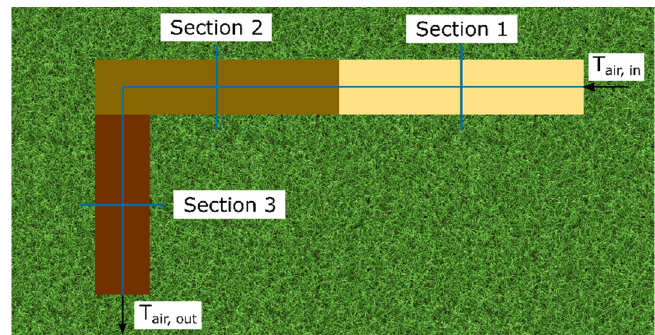
Figure 1. Top-view of the EAHE with section division.